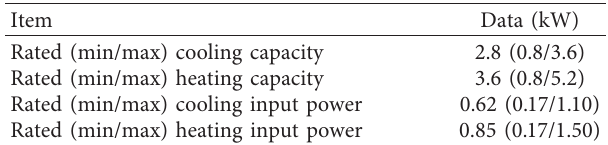
Table 7: Parameters of the frequency conversion air